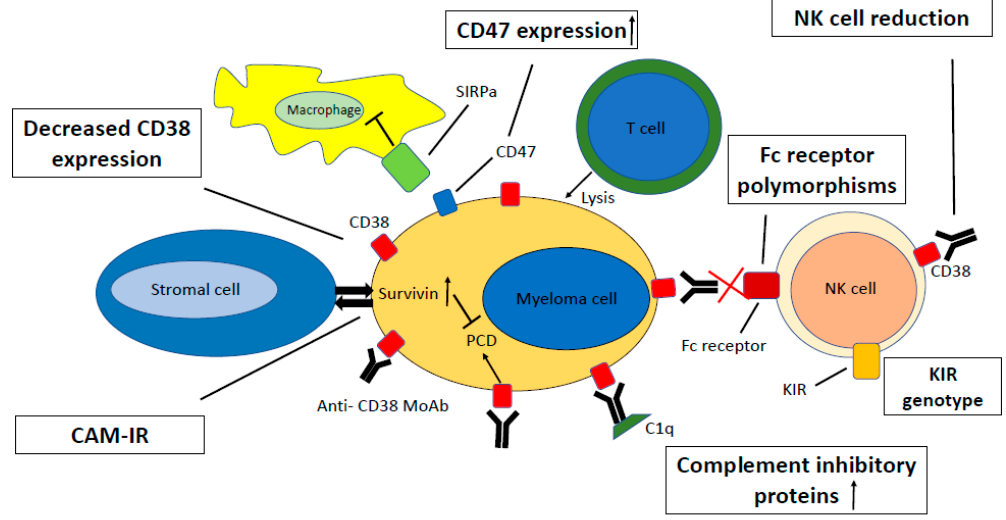
Figure 2. Mechanisms of resistance towards CD38 − directed monoclonal antibodies. The figure displays a multiple myeloma cell expressing CD38, with several potential mechanisms of resistance as explained in the main text. Abbreviations: KIR: killer − cell immunoglobulin-like receptors; PCD: programmed cell death; MoAb: monoclonal antibody; CAM − IR: cell adhesion-mediated immune